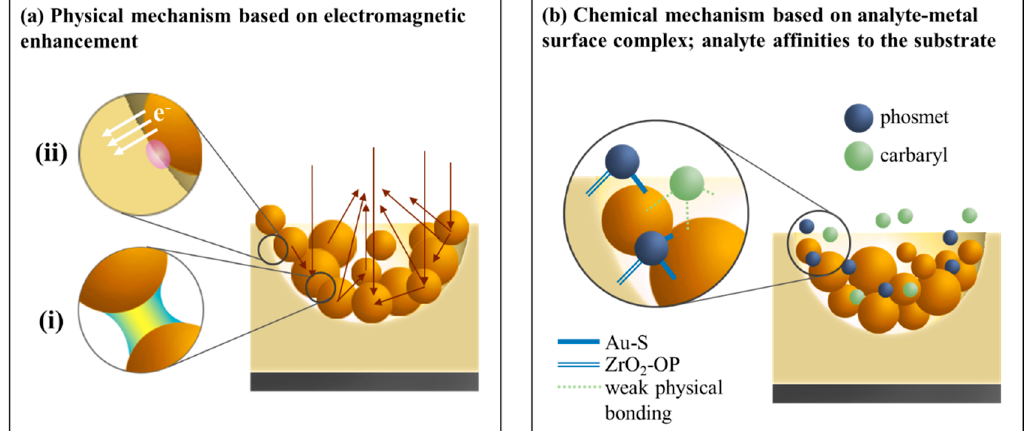
Figure 6. Proposed mechanisms that provide the overall SERS amplification: ( a ) Physical mechanism of the Au/ p ZrO 2 substrate showing two major contributors: (i) Electromagnetic enhancement brought by the formation of hot spots between Au NPs. Additionally, the arrows indicate the convergent scattering of light with respect to the arrangement of Au NPs in a concave cavity, and (ii) interfacial charge transfer between Au NPs and ZrO 2 , and ( b ) Chemical mechanism owing to the formation of analyte-substrate complexes, related to the affinities of the analyte molecules to the substrate.